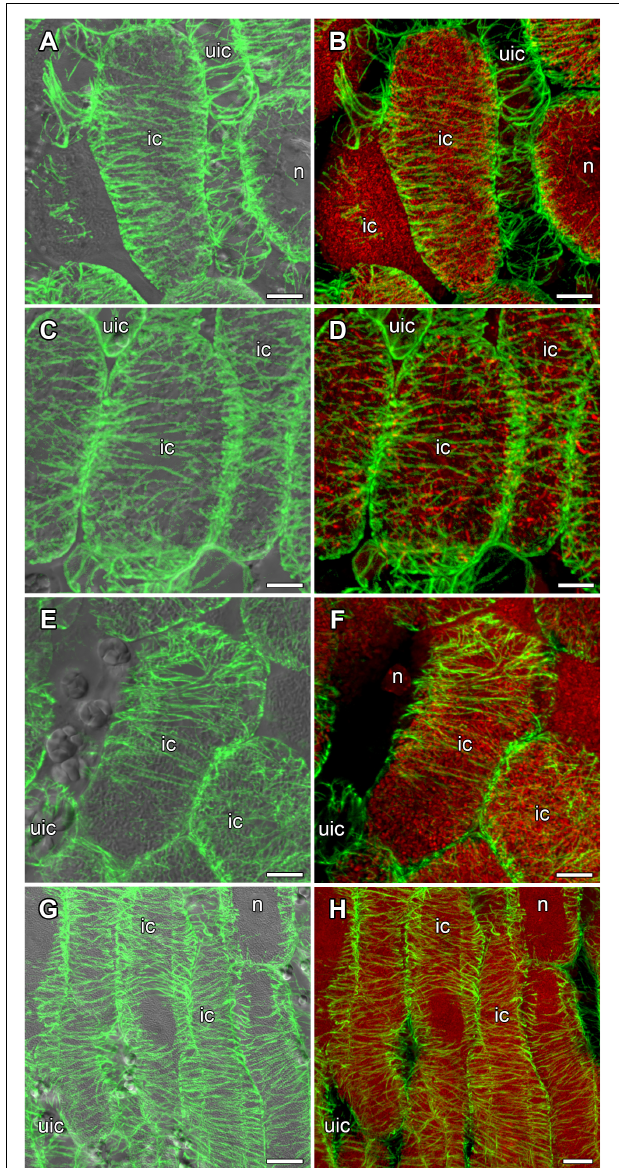
FIGURE 7 | Cortical microtubule organization within infected cells of the nitrogen fixation zone in G. max (A,B) , G. soja (C,D) , P. vulgaris (E,F) , and L. japonicus (G,H) nodules. ic, infected cell; uic, uninfected cell; n, nucleus. Confocal laser scanning microscopy of (A–F) 50 µ m and (G,H) 35 µ m longitudinal vibratome sections. Immunolocalization of tubulin (microtubules), green channel; DNA staining with propidium iodide (nuclei and bacteria), red channel. (A,C,E,G) Merged images of a single optical section of differential interference contrast and maximum intensity projection of optical sections in the green channel. (B,D,F,H) Maximum intensity projections of (B,D) 50, (F) 20 and (H) 55 optical sections in green and red channels. Scale bar = 10 µ m.